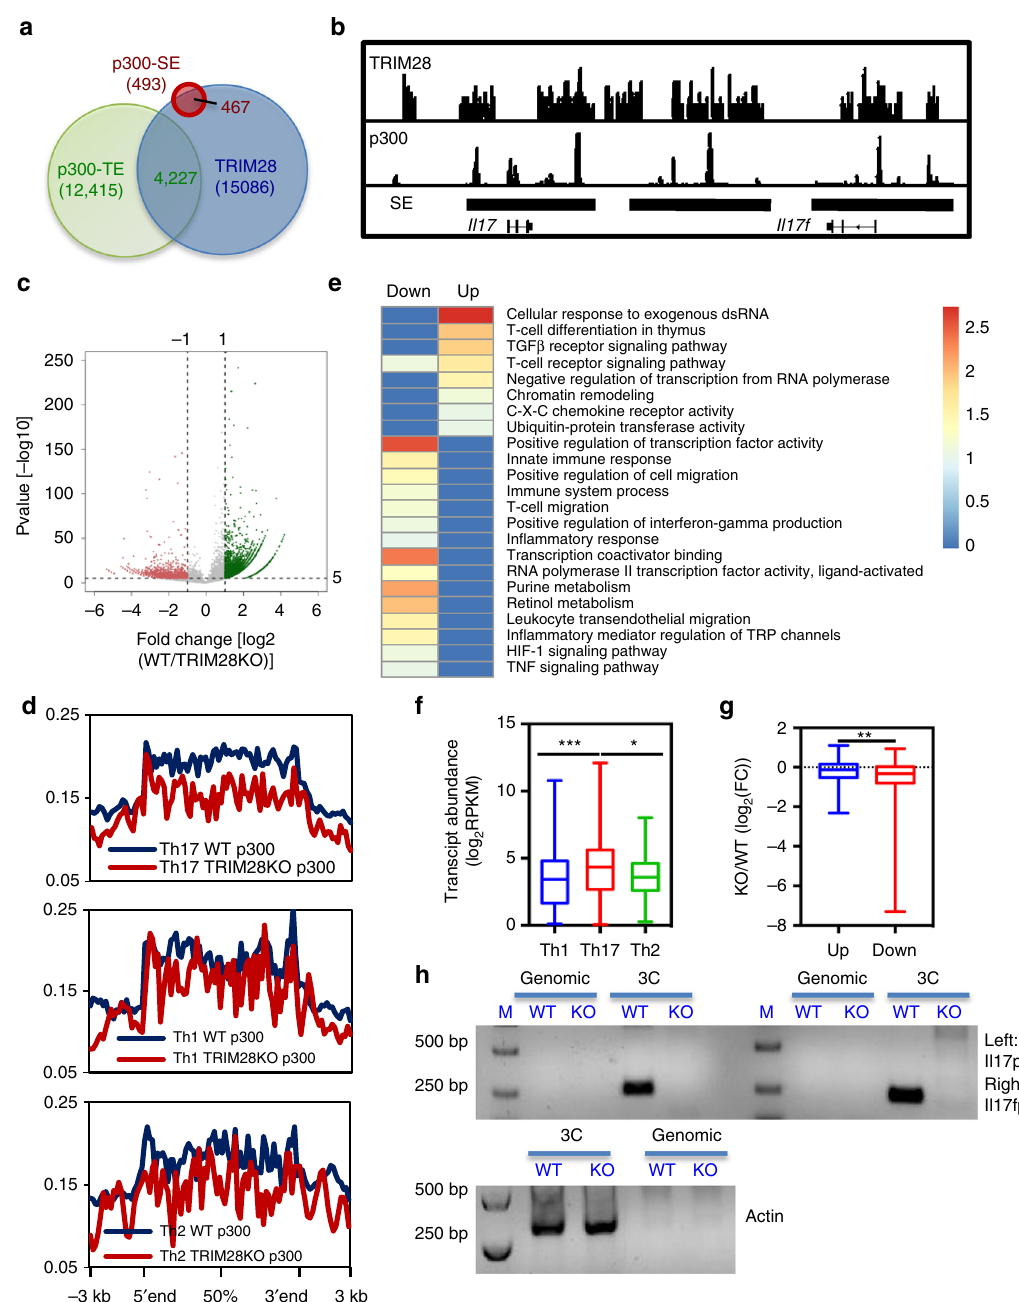
Fig. 5 TRIM28-de fi ciency impaired epigenetic activation in Th17 cells. TRIM28 ChIP-seq was performed as in Fig. 4. a Overlap of TRIM28 binding peaks with SE and TE regions in Th17 cells. b IGV browser view of TRIM28, p300 binding peaks and SE regions at the Il17-Il17f gene locus (right). c Volcano plot showing p300 binding peak change in WT and Trim28 − / − Th17 cells cultured for 3 days (TGF- β + IL-6). d Overlay of p300 binding peaks in WT and TRIM28KO Th17 cells over Th1-, Th2 and Th17-speci fi c SEs with decreased p300 intensity. e Heatmap of pathway analysis in genes associated with Th17- SEs that had decreased (left) or increased (right) p300 recruitment in KO cells. f Transcriptional comparison of T helper-speci fi c SE-associated genes analyzed from WT Th17 RNA-seq data ( p values, Mann − Whitney test). g Fold change of Th17-SE-related genes with increased (up) or decreased (down) p300 binding at the SE regions ( p values, Mann-Whitney test). h 3C-PCR experiments were performed in WT and TRIM28KO Th17 cells cultured as in c and the PCR products were acquired by nest PCR. M is short for marker, and the whole DNA gels are shown in Supplementary Fig. 8. * p < 0.05, ** p < 0.01, *** p < 0.005. All error bars represent SDs. The experiments were repeat twice with consistent